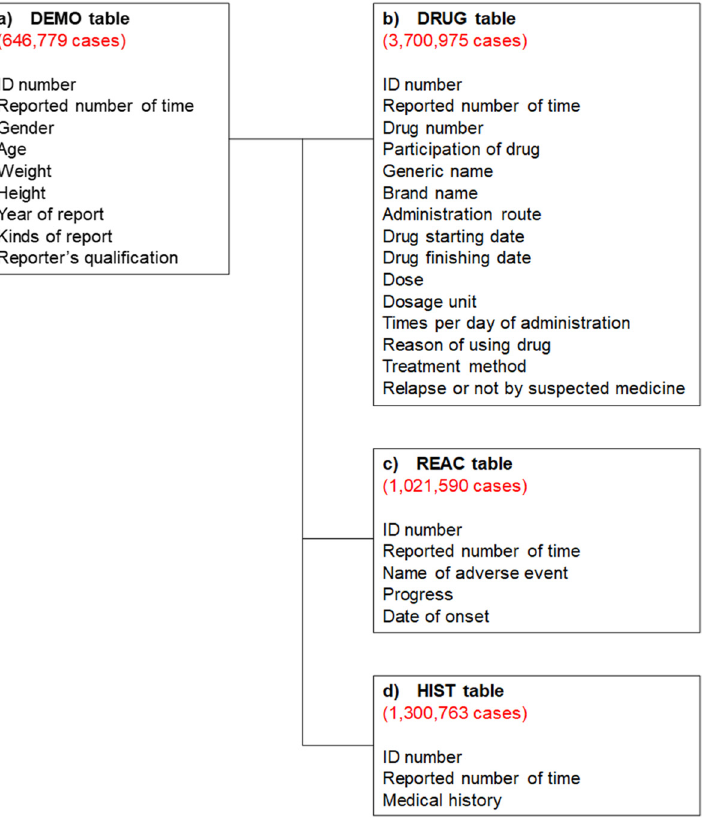
Figure 3. Four information tables included in the Japanese Adverse Drug Event Report (JADER) database. The red numbers show the number of reports obtained between April 2004 and September 2020.